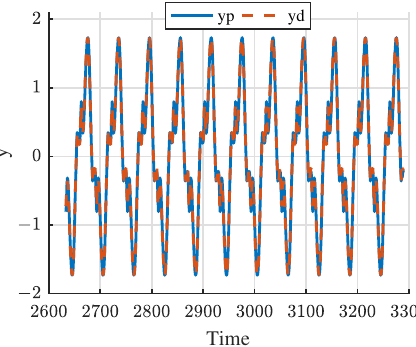
Figure 6. The predicted output with the desired output in 4.2.